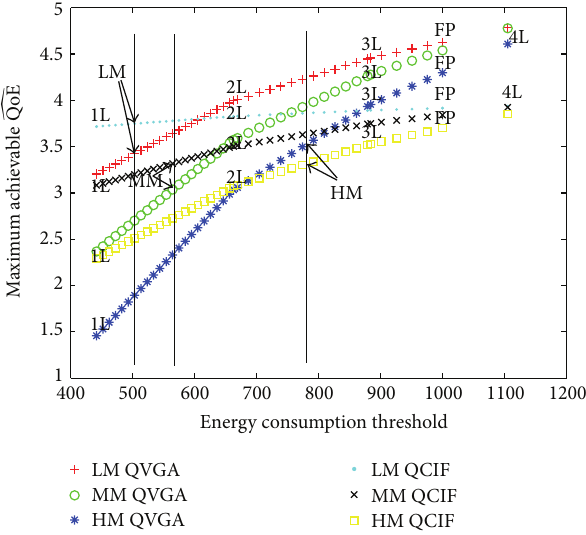
Figure 4: Static versus dynamic QoE optimization for different CTs and SRs.